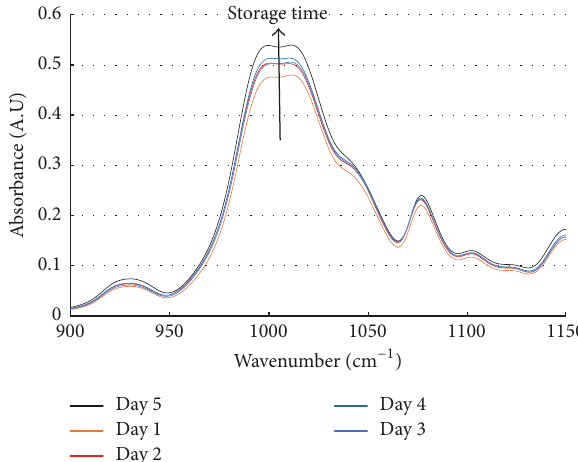
Figure 6: Amplified mean spectra of the normalized bread spectra over 5 days storage at room temperature in the band 900–1150 cm −1 .